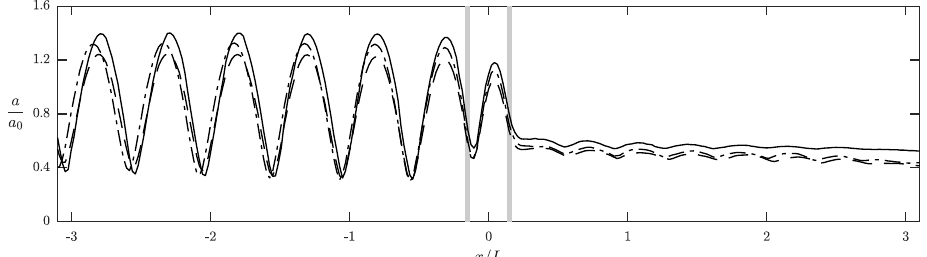
Figure 18. Effects of mud layer thickness on wave scattering by a submerged obstacle: spatial variation of amplitude ratio, a / a 0 . Solid lines: d m = 0 (solid bottom). Dashed lines: d m = δ m . Dashed-dotted lines: d m = 3 δ m . Vertical bars indicate the location of the obstacle. In this case, T = 1.79 s, a 0 = 0.02 m, d = 0.8 m, d u = 0.24 m, d (cid:96) = 0.54 m, ν m = 0.003 m 2 /s, ρ m = 1111 kg/m 3 , L o = 1.2529 m, and D o = 0.02 m. See Figure 1c for the problem definition.